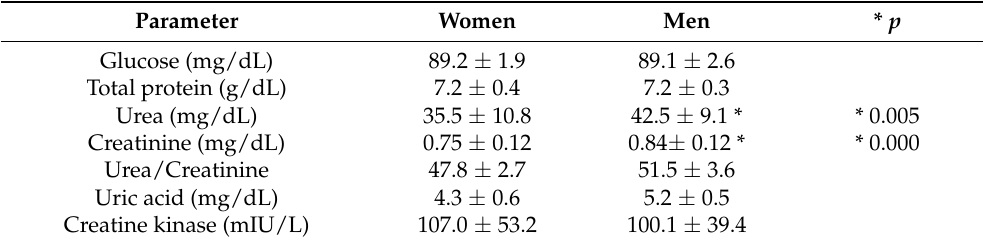
Table 3. Biochemical parameters related to muscle mass and function separated by gender (men and